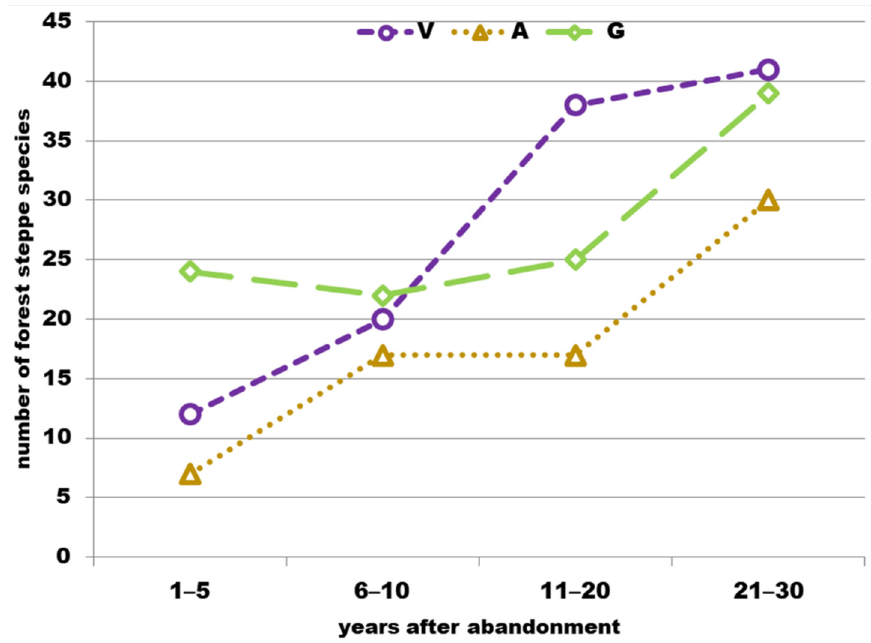
Figure 1. Changes in the total number of forest steppe species in the studied age groups of aban ‐ lands (V—vineyards, A—arable land, doned lands (V—vineyards, A—arable land, G—grasslands).